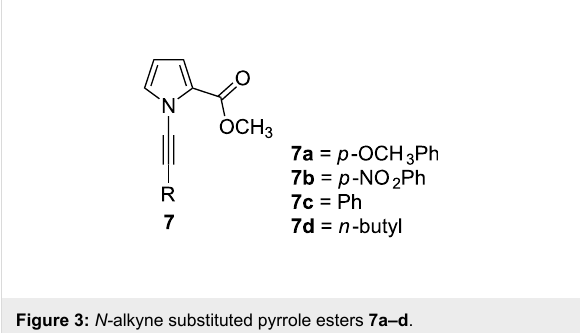
Figure 3: N- alkyne substituted pyrrole esters 7a–d